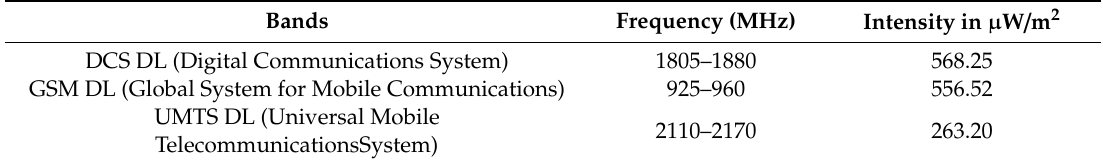
Table 2. The three bands that contribute most to the total intensity of Radiofrequency Electromagnetic Fields (RF-EMF).